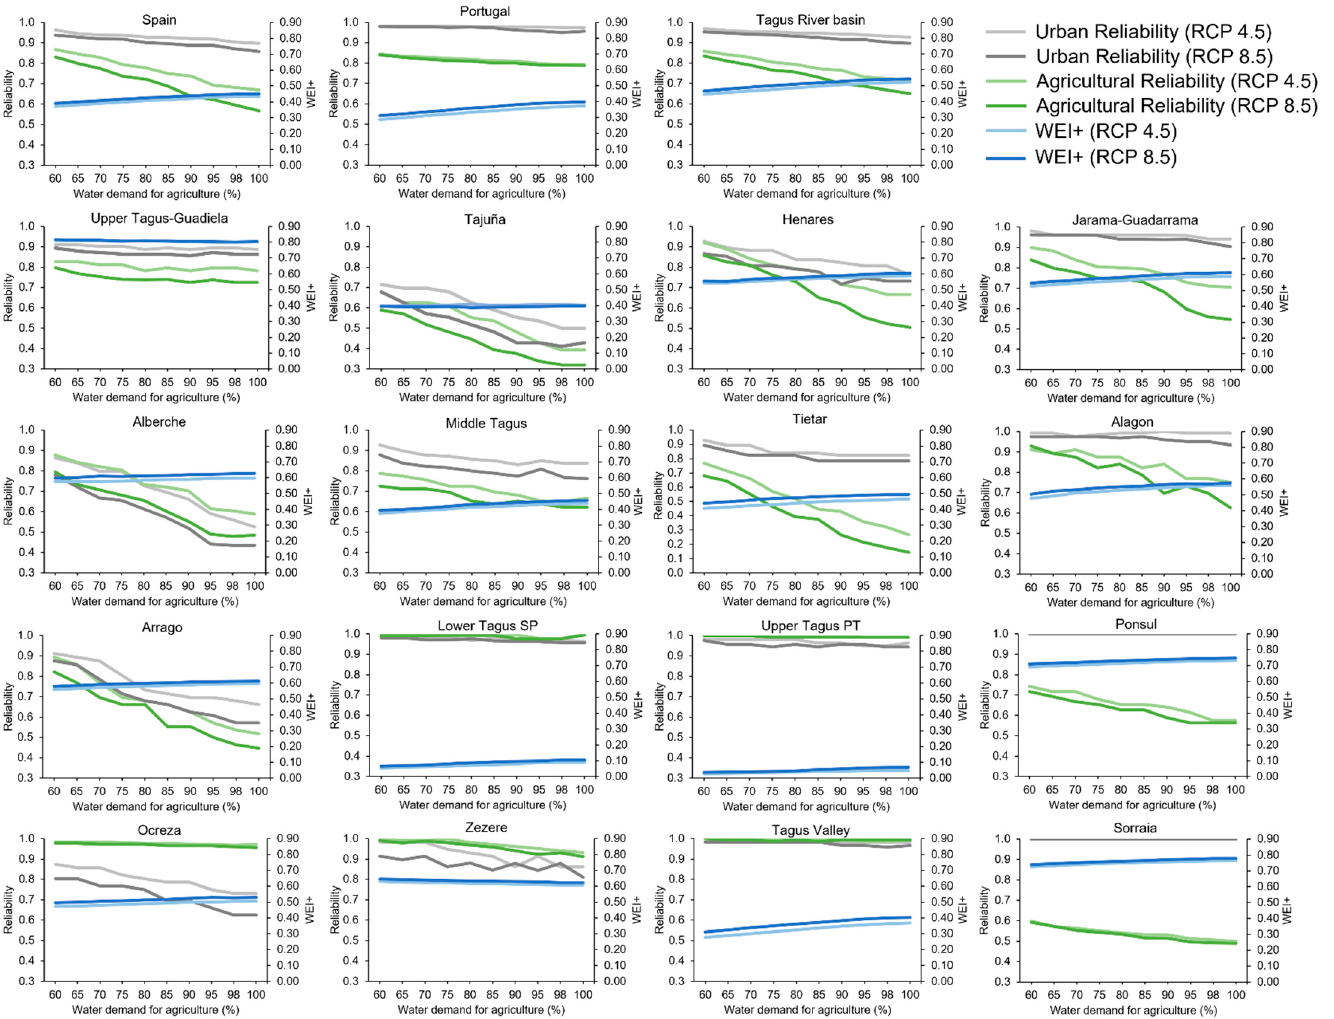
Figure 7. Alternative 1 of reductions in water demand in sub-basins, Spain, Portugal, as well as in the entire Tagus River basin, for mid-term horizon (2040 – 2070) under RCP 4.5 and RCP 8.5.